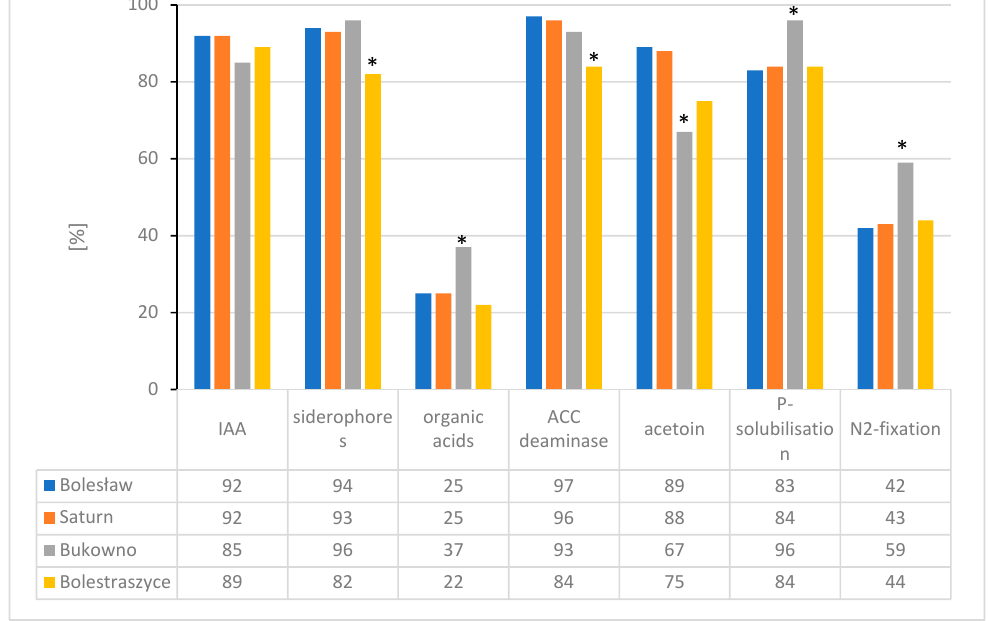
Figure 6. Percentages of strains isolated from rhizosphere soil and tissues of T. repens originating from the Bolesław, Saturn, and Bukowno metalliferous waste heaps and the Bolestraszyce non-polluted reference area demonstrating the tested in vitro plant growth promotion traits. The asterisks indicate statistically significant di ff erences at p <